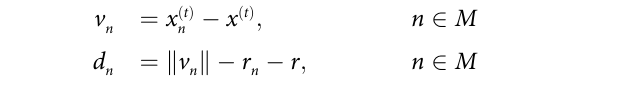
ffiffiffiffiffiffiffiffiffiffiffiffiffiffiffiffiffiffiffiffiffiffiffiffiffiffiffi 2 D Q ð r Þ R ð g Þ